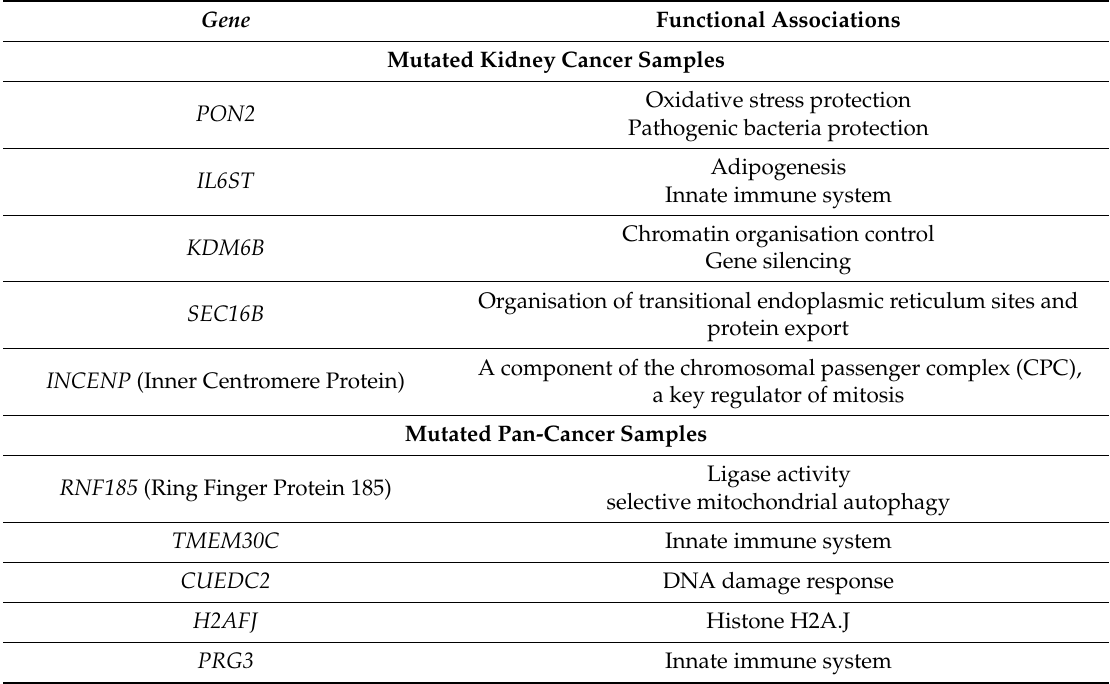
Table 1. Gene mutations associated with an increased distance in signature composition between wild type and mutated kidney cancer samples / mutated pan-cancer